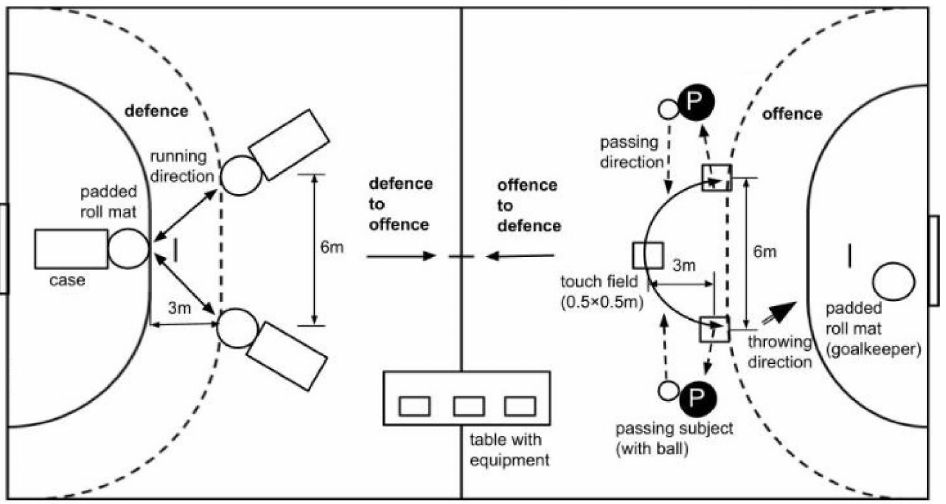
Figure 1. Schematic diagram of the team handball specific game-based performance test (GBPT) including measuring and testing equipment